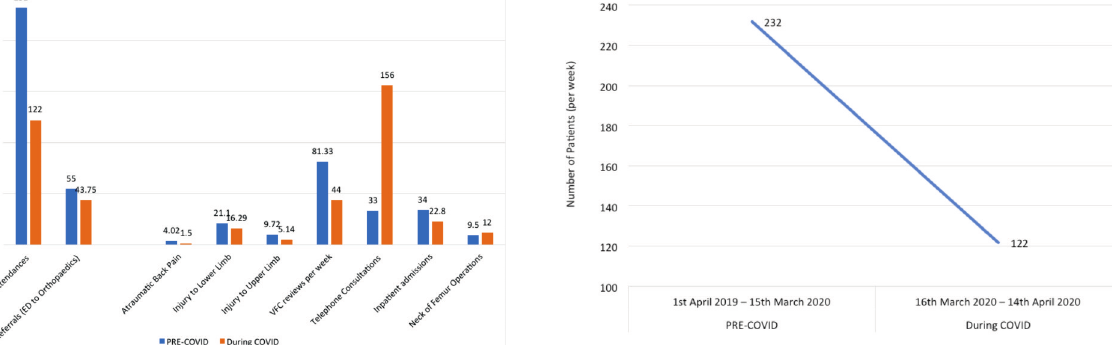
Graph showing the change in numbers of patients being Fig. 1: referred to Trauma and Orthopaedics, neck of femur fractures and number of virtual fracture clinic and telephone consultations (per week).